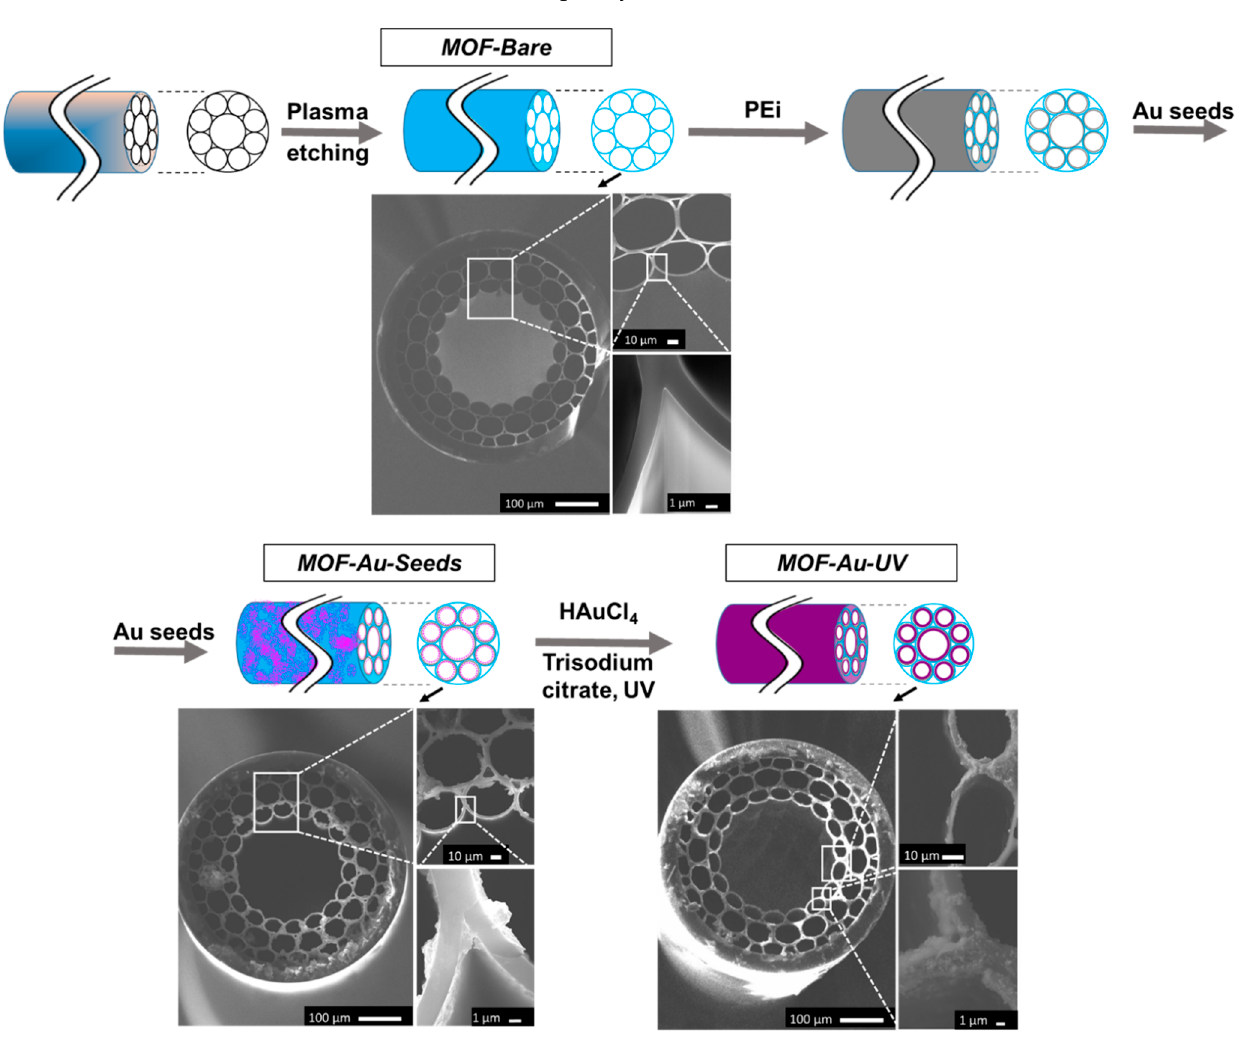
Figure 4. The fabrication process of SERS-active HC-MOFs with SEM images incorporated.